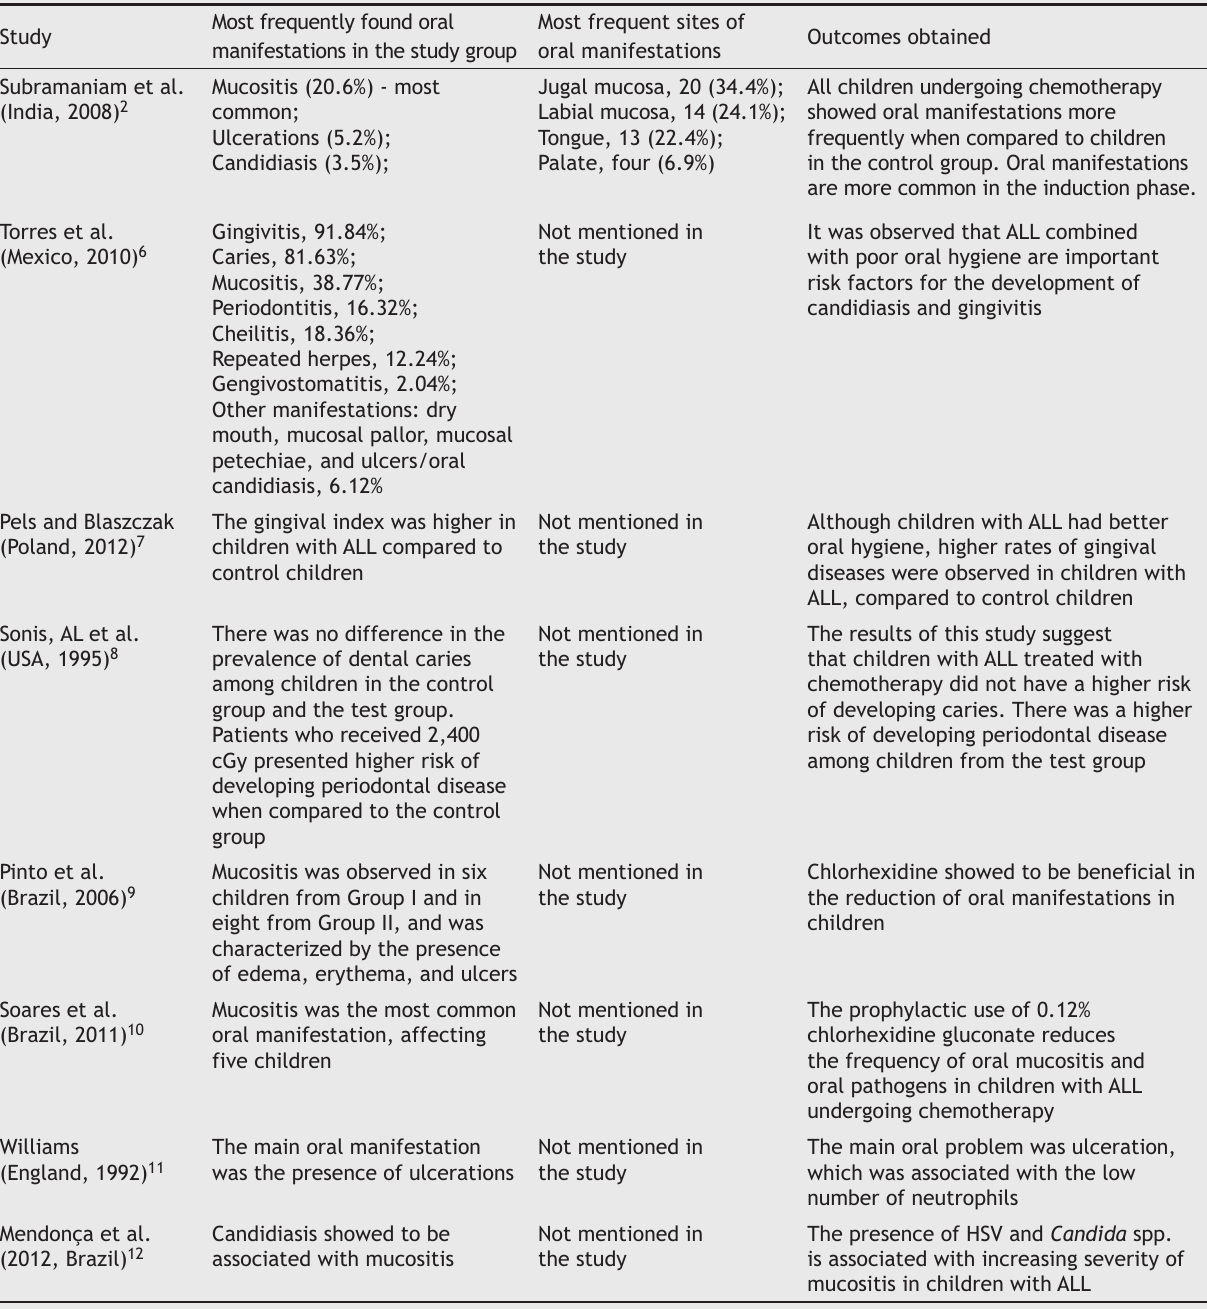
Table 3 Outcomes obtained from the studies selected in the search. Study